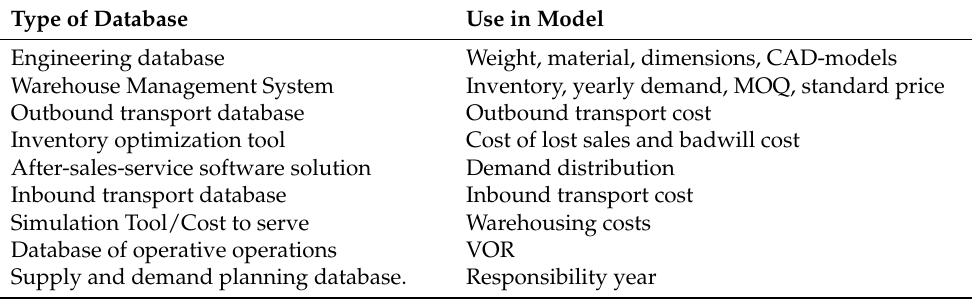
Table A1. List of the OEM’s databases and systems used in this research. Type of Database Engineering